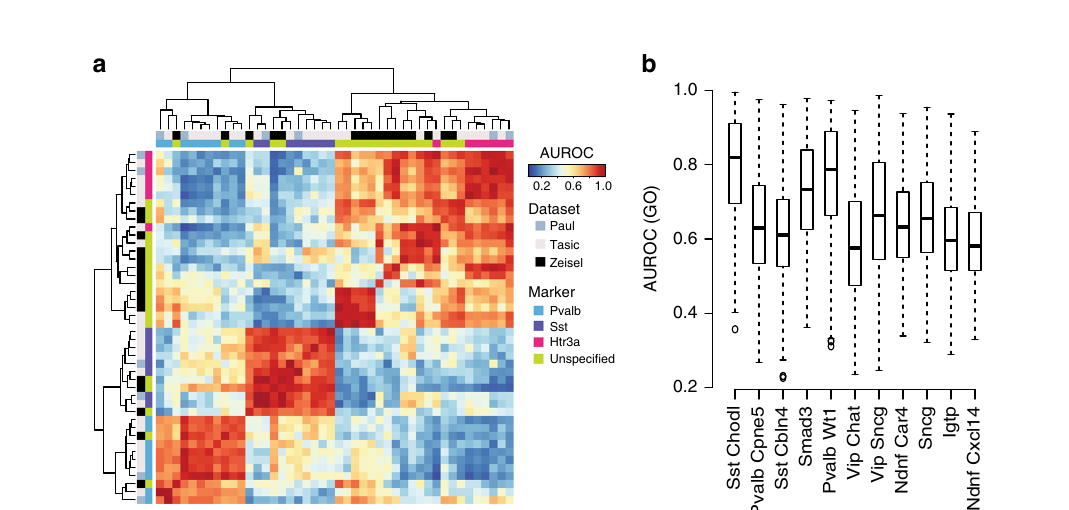
Fig. 4 Cross-dataset analysis of interneuron diversity. a Heatmap of AUROC scores between interneuron subtypes based on the highly variable gene set (HVG). Dendrograms were generated by hierarchical clustering of Euclidean distances using average linkage. Row and column colors indicate data origin and marker expression. Clustering of AUROC score pro fi les recapitulates known cell-type structure, with major branches representing the Pv, Sst, and Htr3a lineages. b Boxplots of GO performance (3888 sets) for each putatively replicated subtype, ordered by their AUROC score from the highly variable gene set. Subtypes are labeled with the names from Tasic et al. A positive relationship is observed between AUROC scores from the highly variable set and the average AUROC score for each